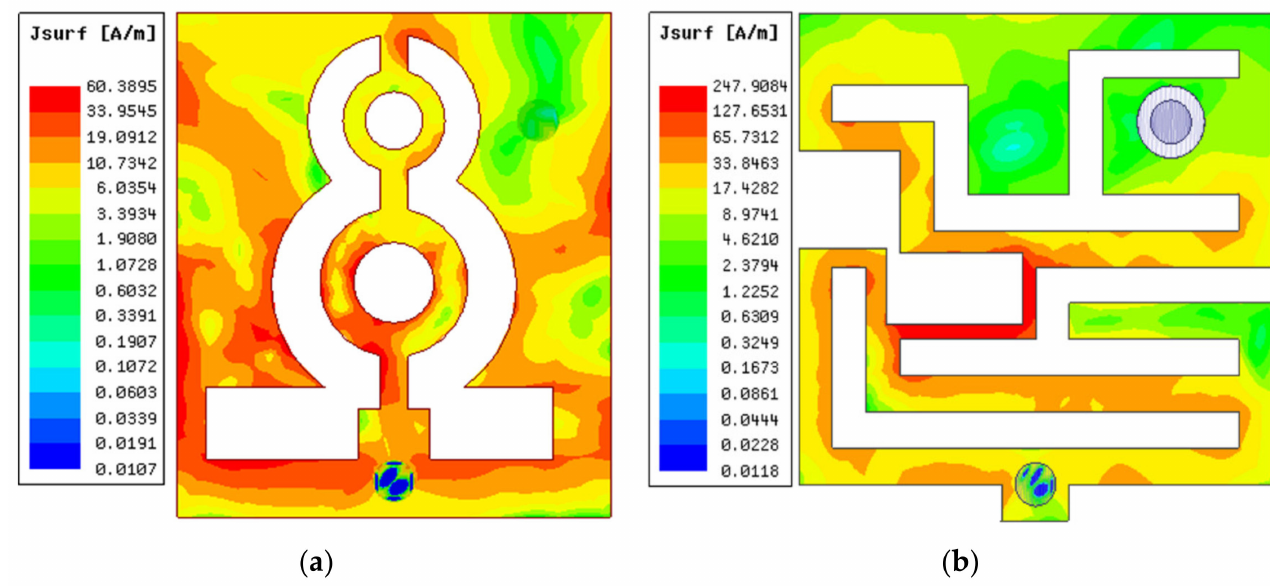
Figure 6. Current distribution at 915 MHz throughout the ( a ) patch and ( b )